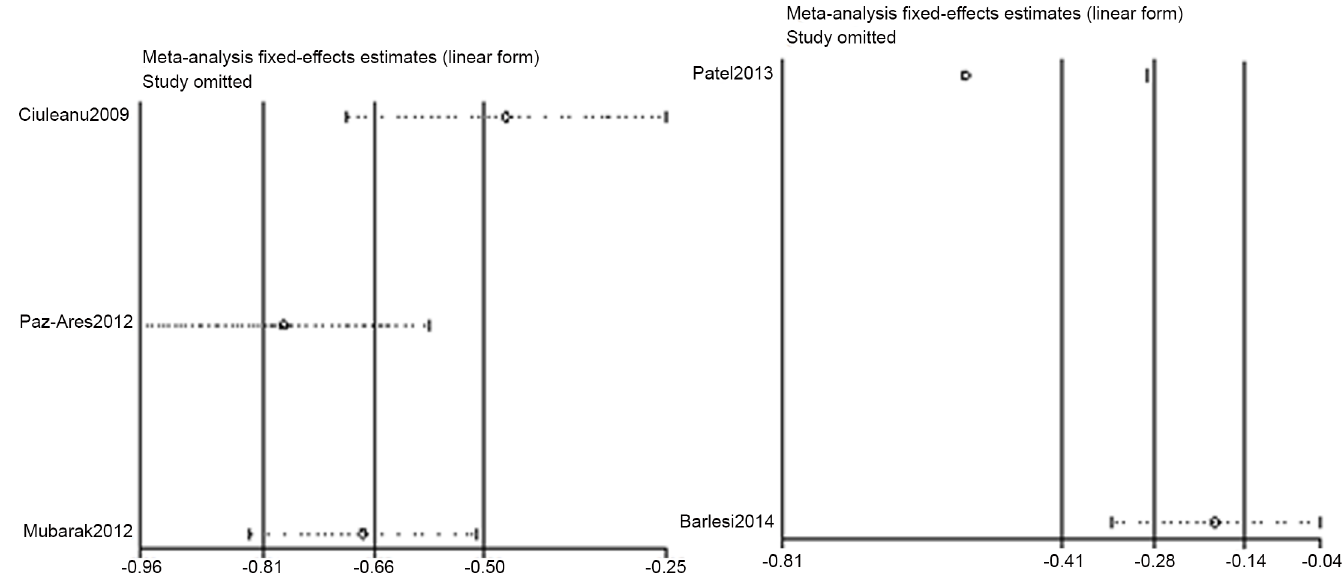
Fig 6. Sensitivity analysis result of PFS.